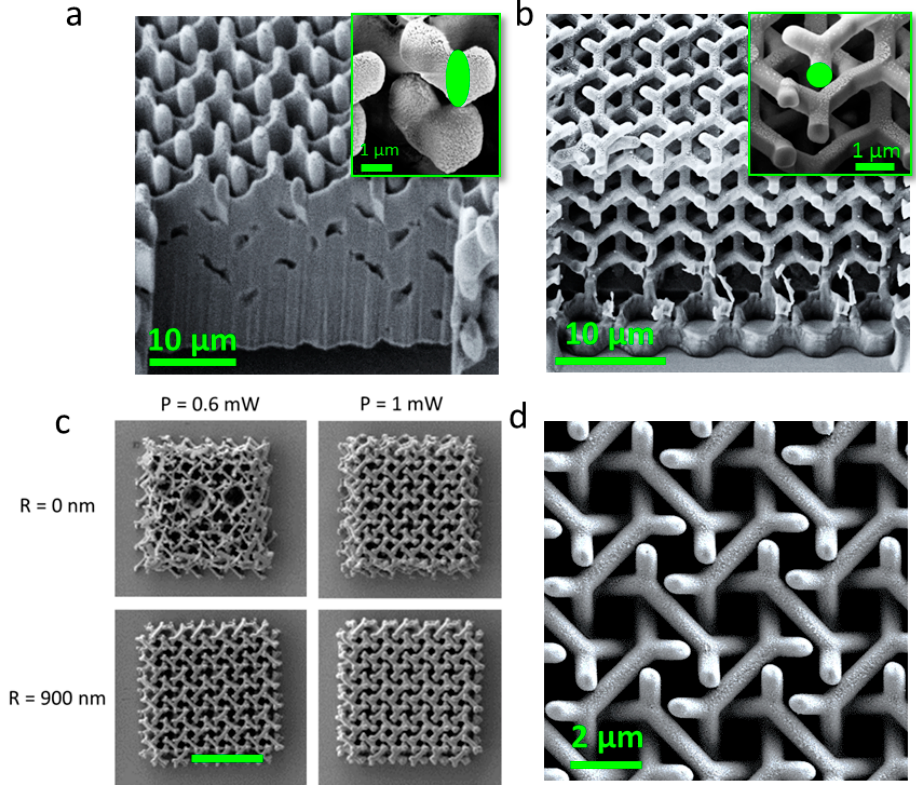
Figure 3. Fabrication results. SEM images of focused ion beam cut polymer achiral 2-srs networks fabricated with ( a ) traditional direct laser writing (DLW) method and ( b ) GD-DLW showing a transition from elliptical to circular cross section respectively. In the inserts, cross sections are highlighted in green. ( c ) Top view of 8-srs PhCs fabricated using both DLW and GD-DLW. ( d ) Top view of an optimized 8-srs PhC.